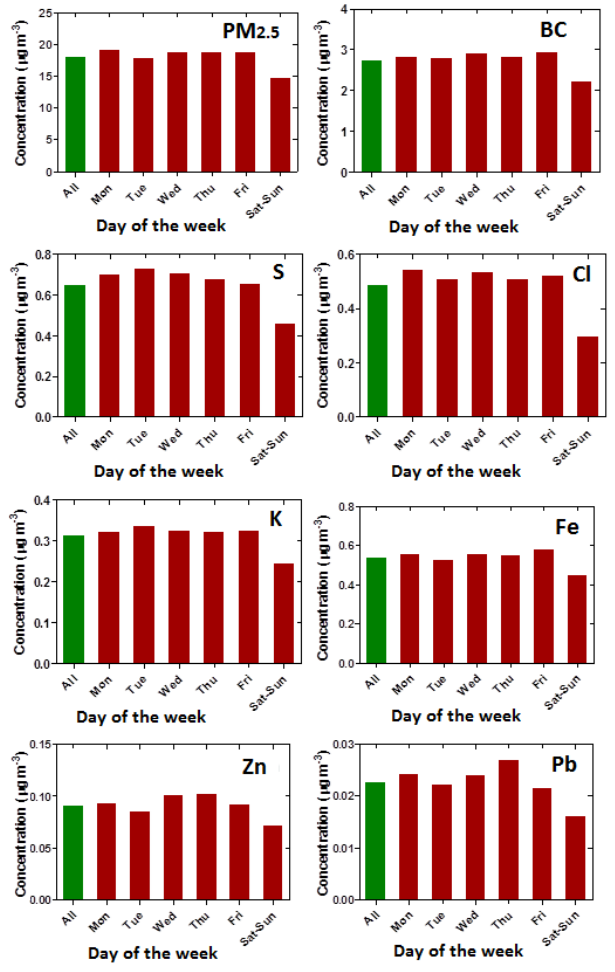
Figure 6. Weekly variation of PM 2 . 5 and some selected elements showing the trend based on calculated averages from respective days of the week.